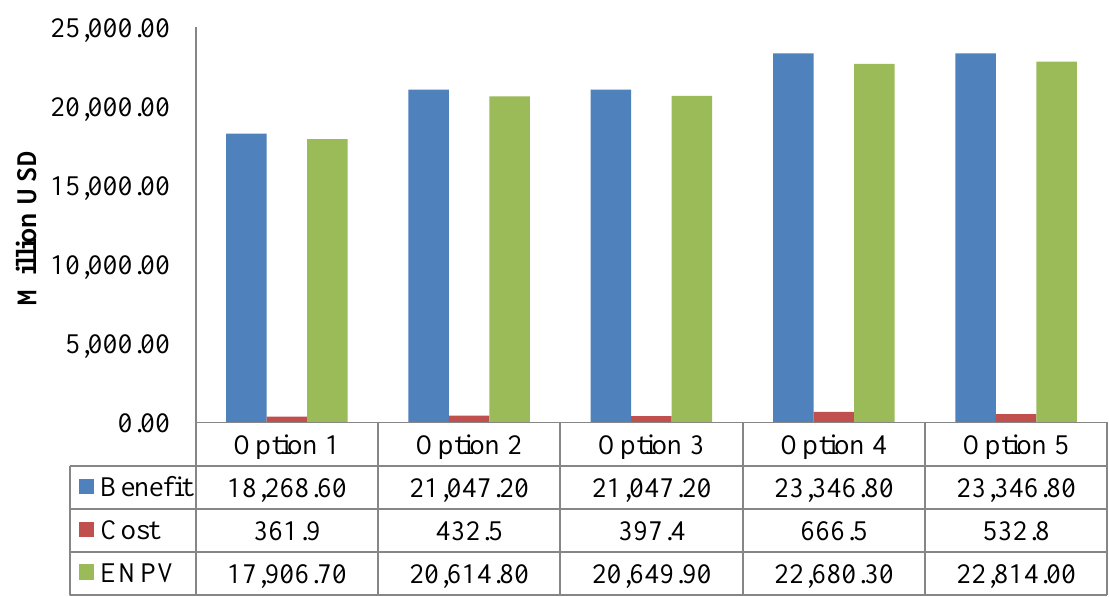
Figure 5. Cost-benefit analysis of different dike options with sensitivity analysis (discount rate = 3%, salinized areas =